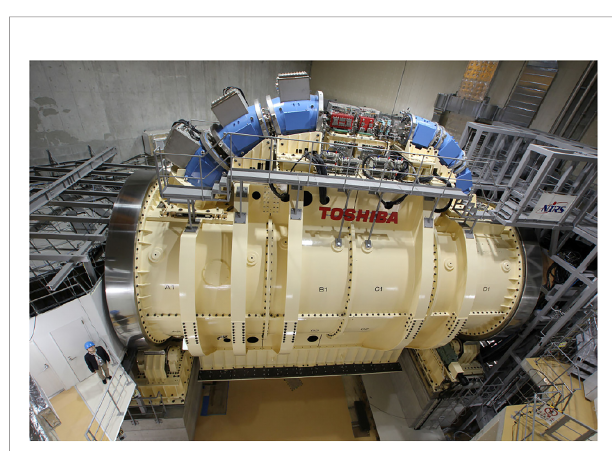
FIGURE 4 | Toshiba ’ s gantry with superconducting technology capable of 360° rotation about the isocenter – after